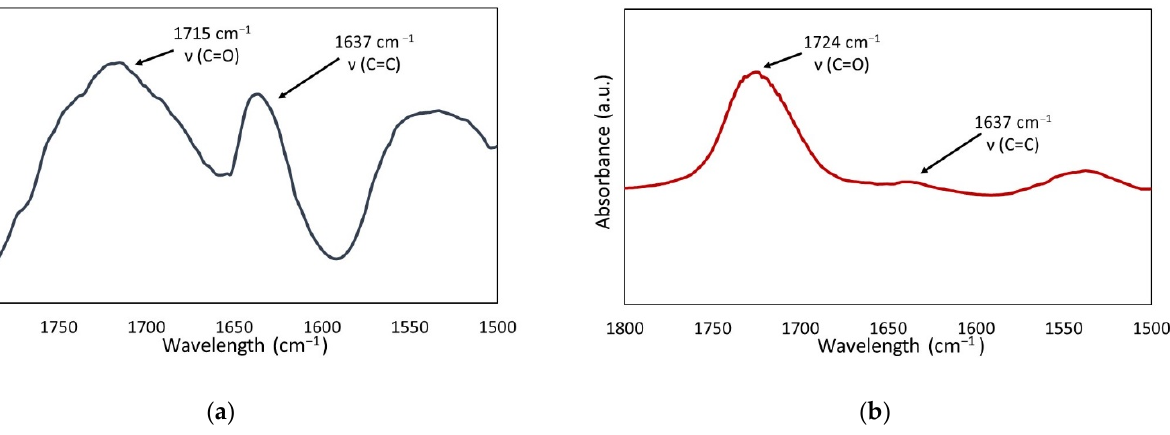
Figure 3. The representative FT IR spectra of the QA16:TEG: ( a ) liquid monomer composition and ( b ) copolymer.